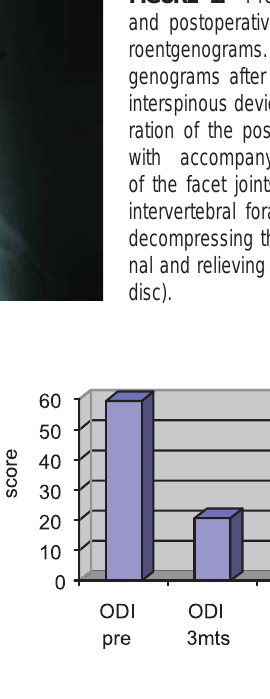
FIGURE 3. The symptom improvement measured by ODI scale. ODI pre: preoperative ODI score; ODI 3mts: ODI score 3 months after surgery.